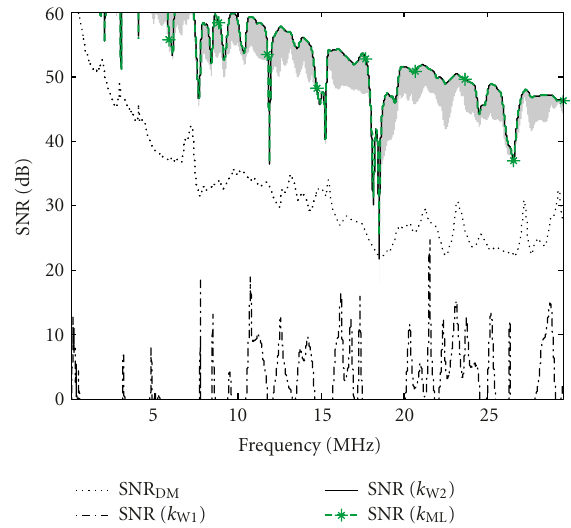
Figure 4: SNRs of adaptive cancellation compared to processing only the DM signal for a transmission over a loop of 300m length with one FEXT source ( S = 1) located at the same distance and transmitting with the same PSD of − 60 dBm/Hz as the far-end transmitter. The background-noise level on both DM port and CM port is − 140 dBm/Hz. The grey-shaded area indicates SNR values for coe ffi cient mismatch of up to 10% (SNR( K 0 . 1